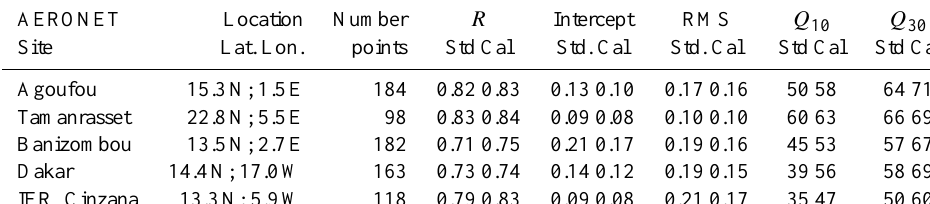
Table 1. Summary statistics of OMAERUV and AERONET aerosol optical depth comparison.